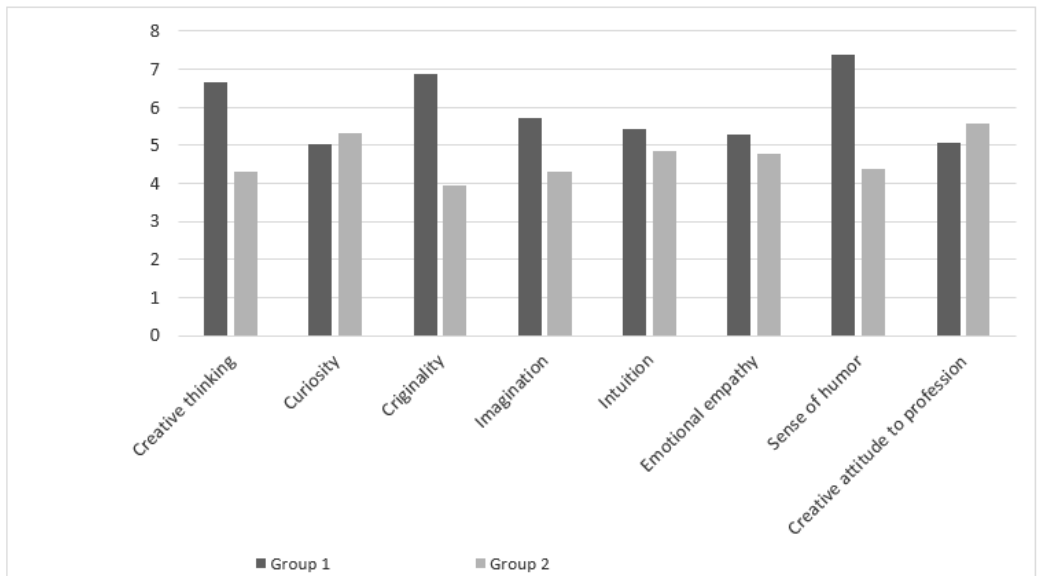
Figure 3. Comparative results of differences (average values) by the method of N. Vish